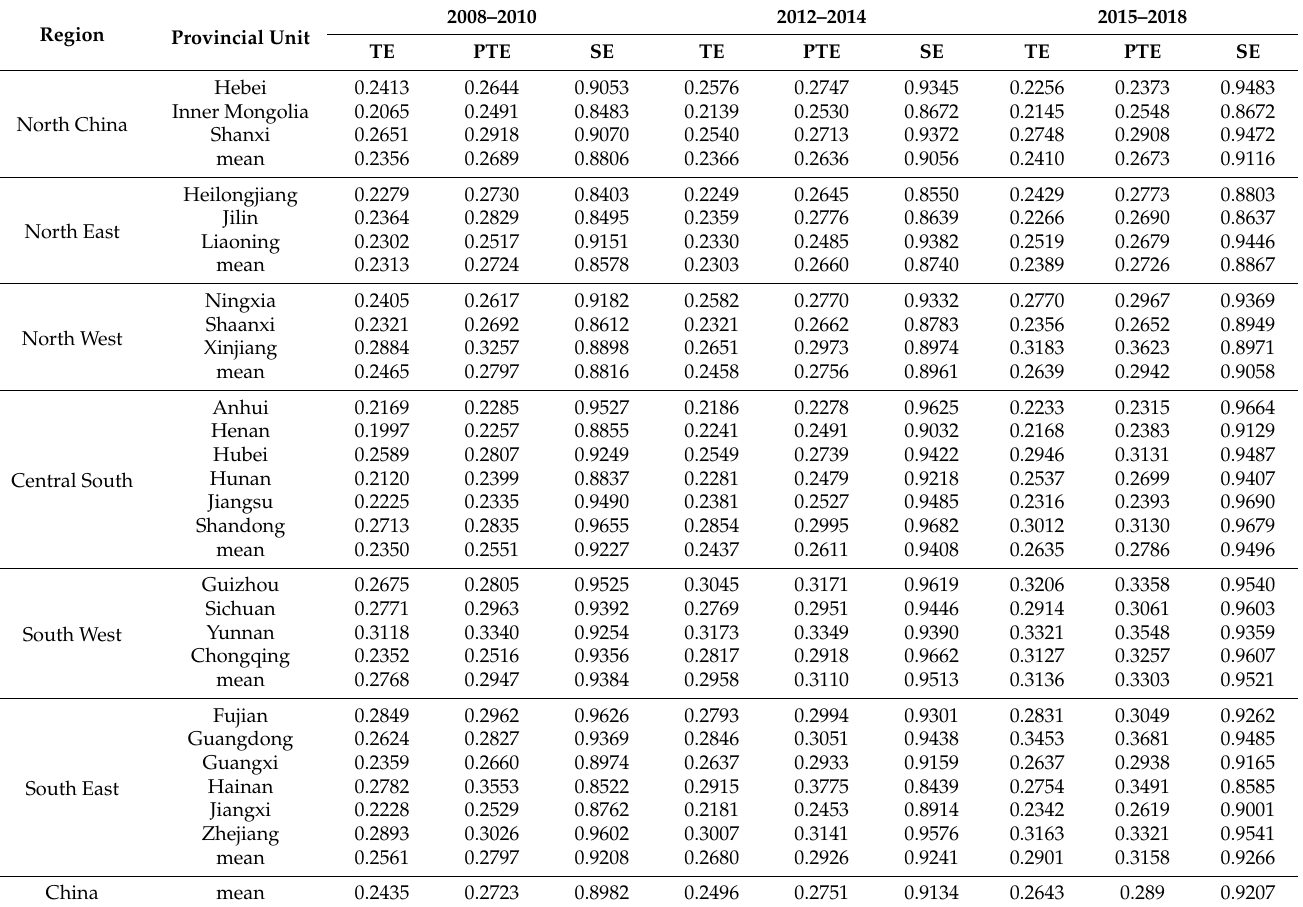
Table 4. Carbon sequestration output efficiency of China’s state-owned forest farms in the third stage. Region Provincial